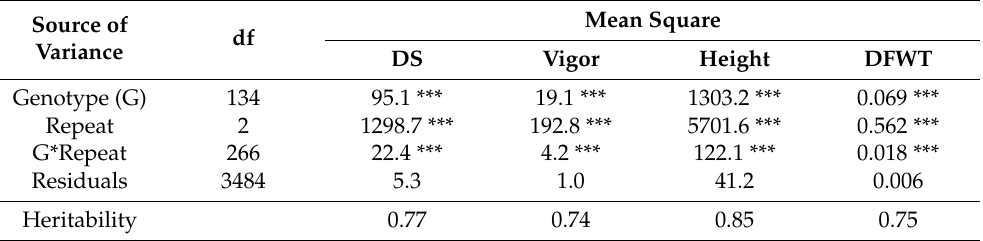
Table 1. ANOVA for root rot severity, vigor, dry foliar weight and plant height using the pooled data of a recombinant inbred line (RIL) population of pea inoculated with Aphanomyces euteiches in three greenhouse